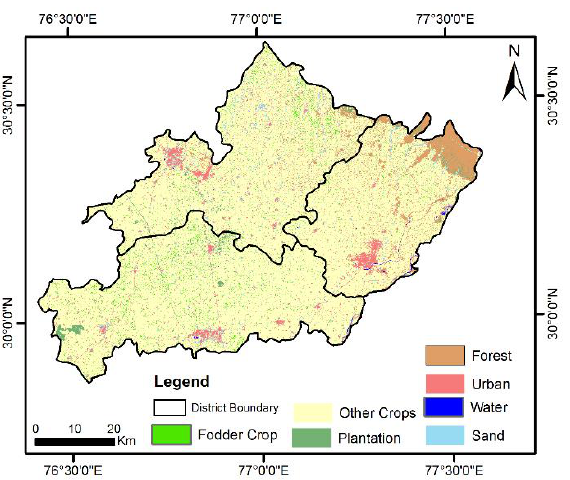
Figure 5. MLC image of study area with Ground truth Points